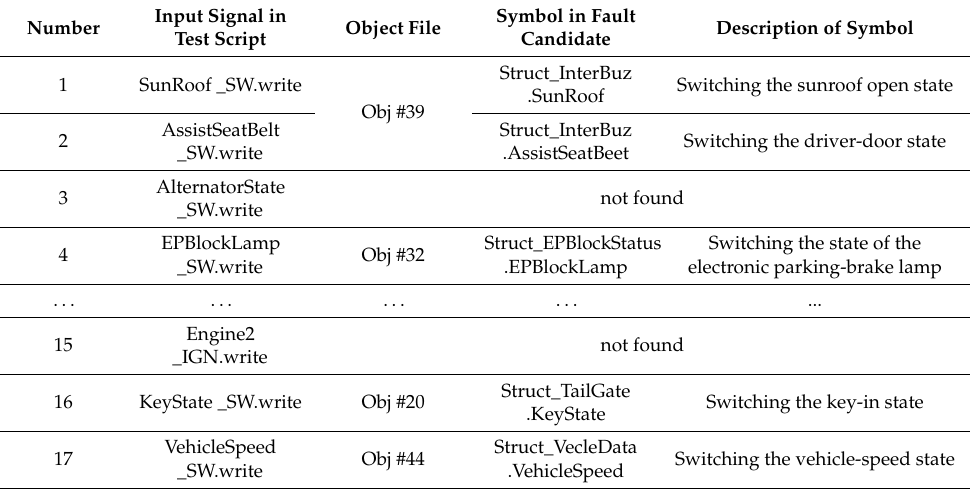
Table 3. Correlation between test input and fault candidate symbol based on memory map.